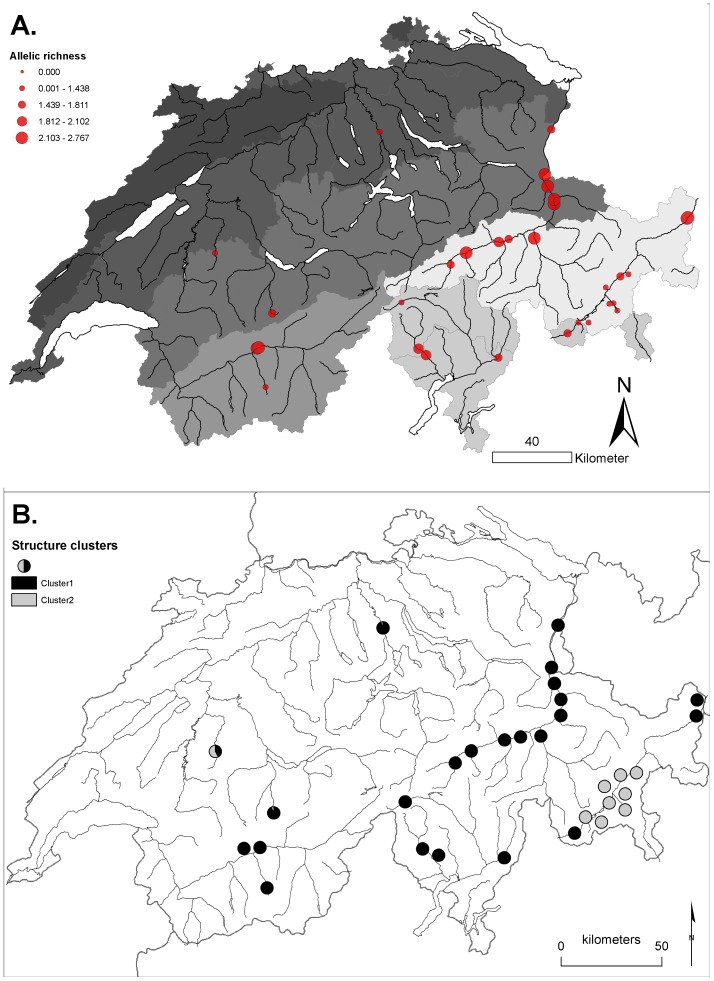
Allelic richness and cluster affiliations of the studied sites of Myricaria germanica (Tamaricaceae) in Switzerland.A. Allelic richness. The shading of the map shows biogeographic regions of Switzerland, as used in analysis of molecular variance. B. Results from Bayesian analysis of population structure. Map data: modified from Vector25 © 2011 swisstopo (contract number 5704000000); biogeographic regions: modified following data from BAFU, CH-3003 Bern, Switzerland.